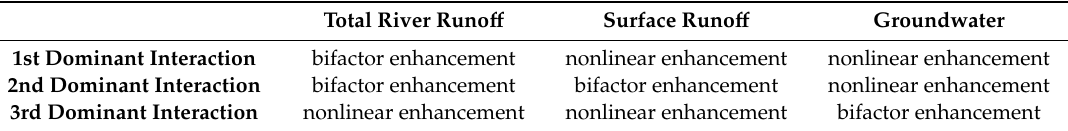
Table 10. Interaction modes of the factors on runo ff in the small relief mountain region.